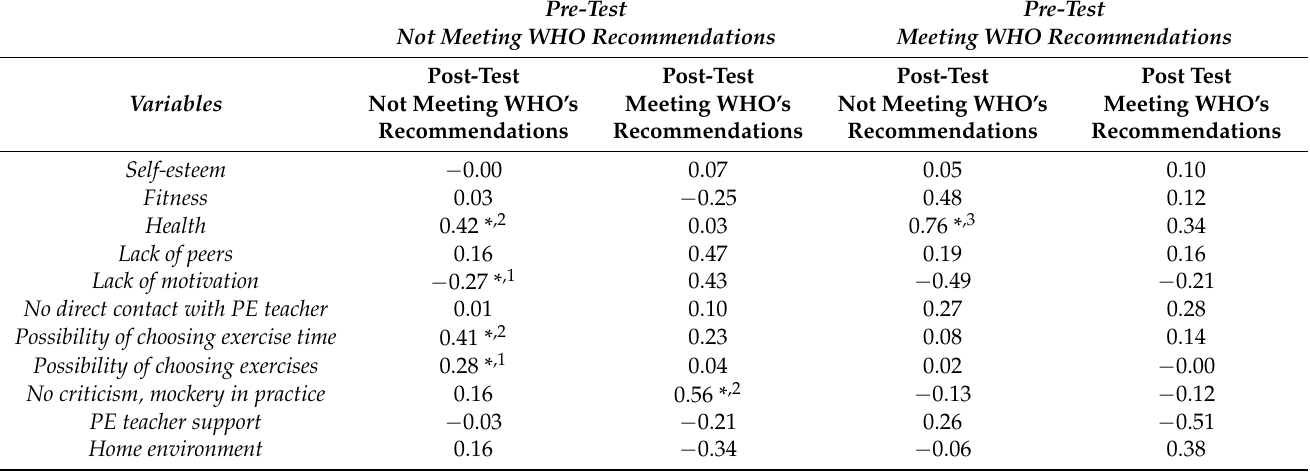
Table 1. Correlation among study variables .